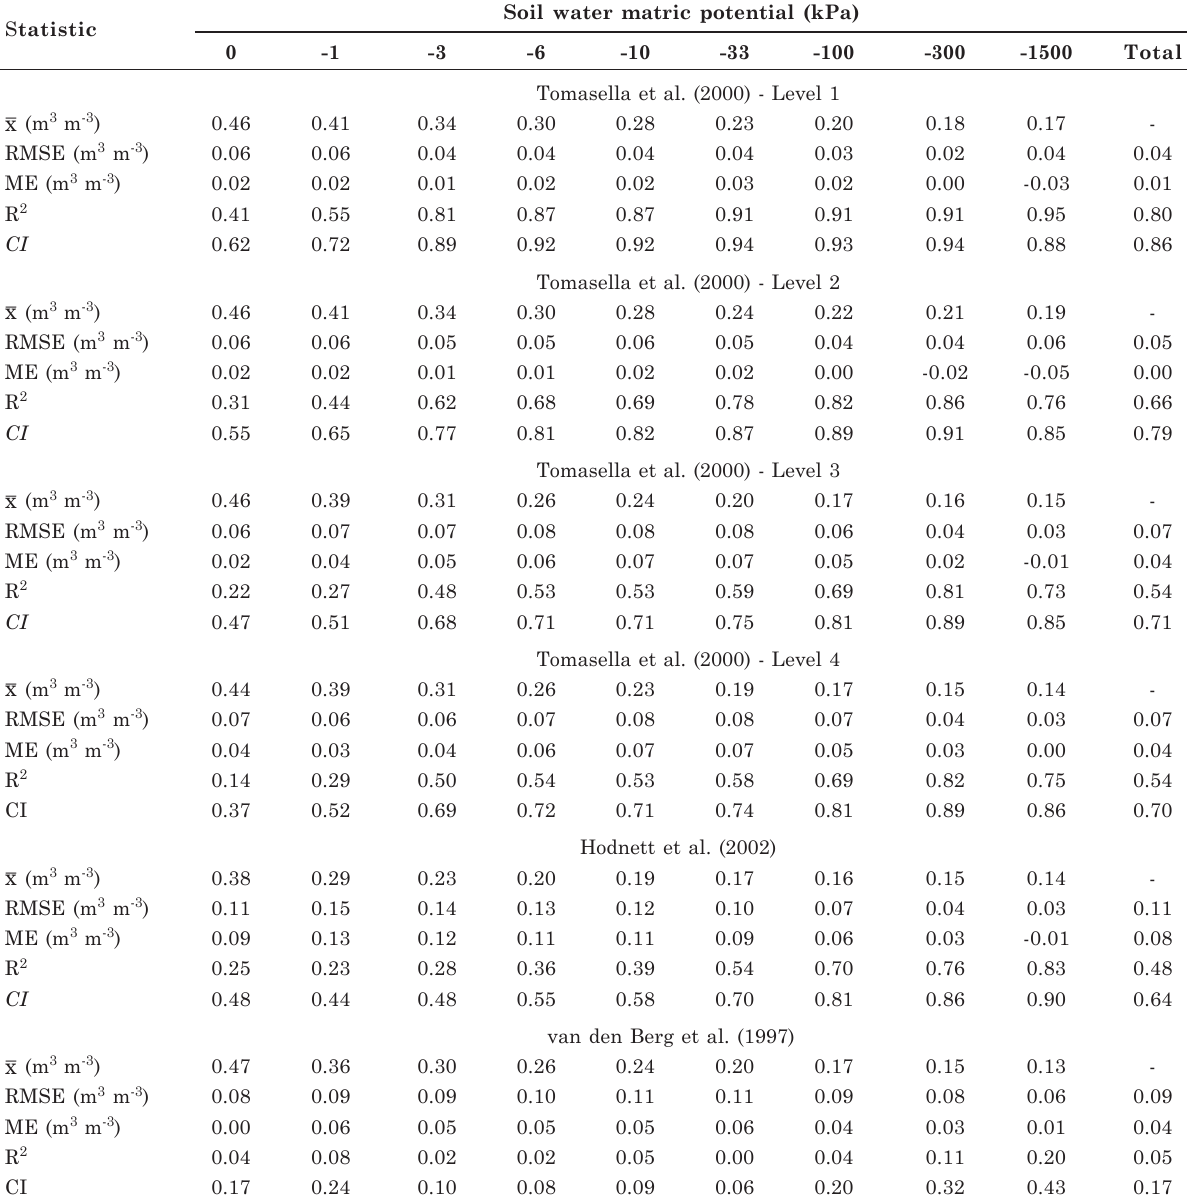
Table 5. Statistical indicators for the parametric PTFs tested for the topsoil layer (0-5 cm). n =